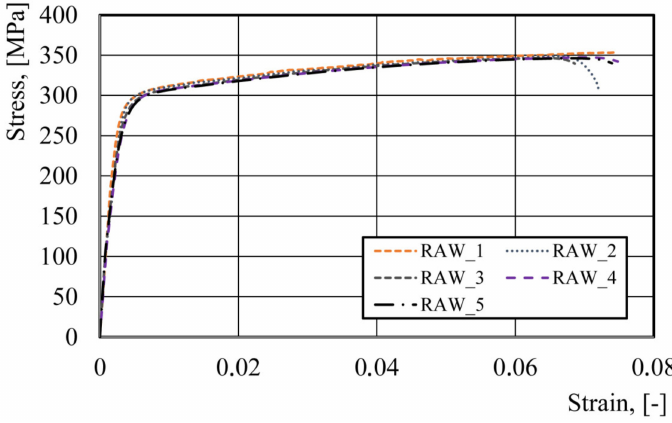
Figure 8. Stress–strain curves for the miniaturized samples of the raw material.